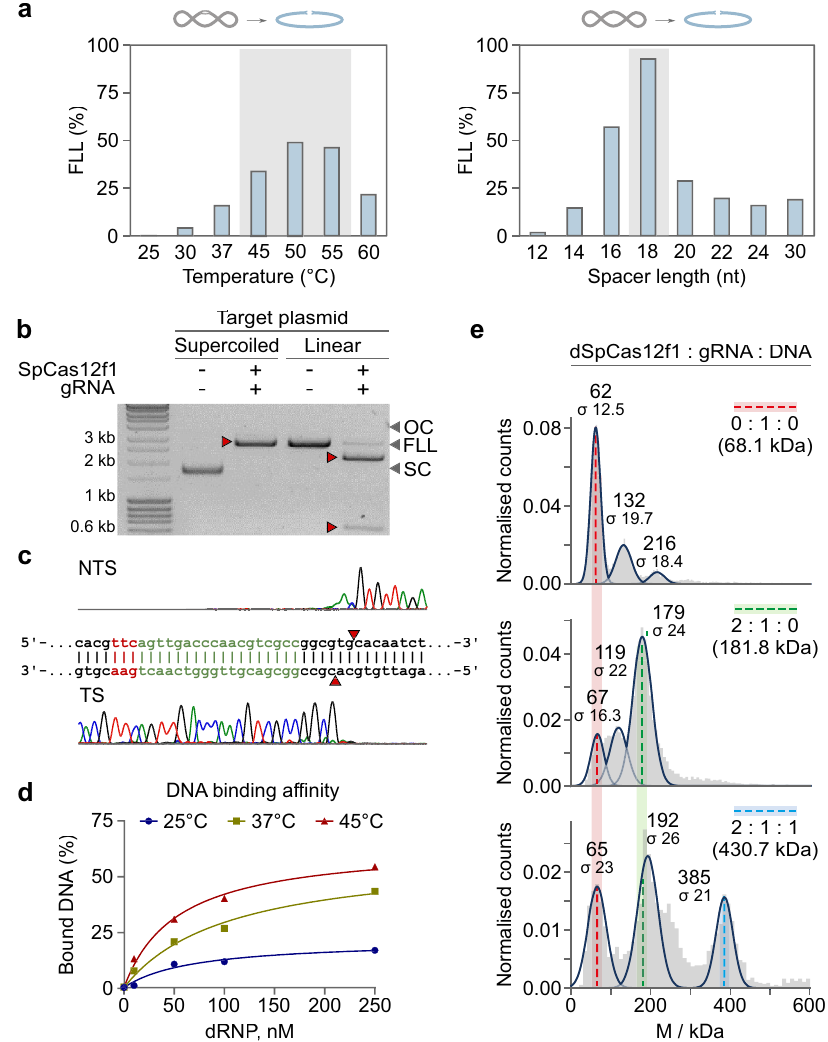
Fig. 2 SpCas12f1 DNA cleavage and binding activity in vitro. a Supercoiled plasmid DNA cleavage at different temperatures (left panel) and cleavage dependence on gRNA spacer lengths at 45 °C (right panel). b SpCas12f1 cleavage of supercoiled and linear DNA forms in vitro. Source data are provided as a Source data fi le. c Run-off sequencing of SpCas12f1 cleavage products (cutting is centered around 22 – 24 bp 3 ’ from the PAM). NTS and TS represent non-target and target strands, respectively. d Dependence of dsDNA-binding ef fi ciency on temperature. Nuclease inactivated or dead (d) SpCas12f1 (D228A) RNP was mixed with dsDNA and preincubated for 30 min at the temperatures shown. DNA binding was monitored by EMSA (electrophoretic mobility shift assay) and quanti fi ed. e Molecular masses of complexes measured by mass photometry. Colored dashed lines indicate the observed molecular weights for the different components: red — gRNA, green — dCas12f1 – gRNA binary complex, blue — dCas12f1 – gRNA – DNA ternary complex. The theoretical masses for the given complex stoichiometries are shown in brackets. For all experiments, SpCas12f1 or dSpCas12f1 RNP complexes were assembled using a gRNA with an 18 nt long